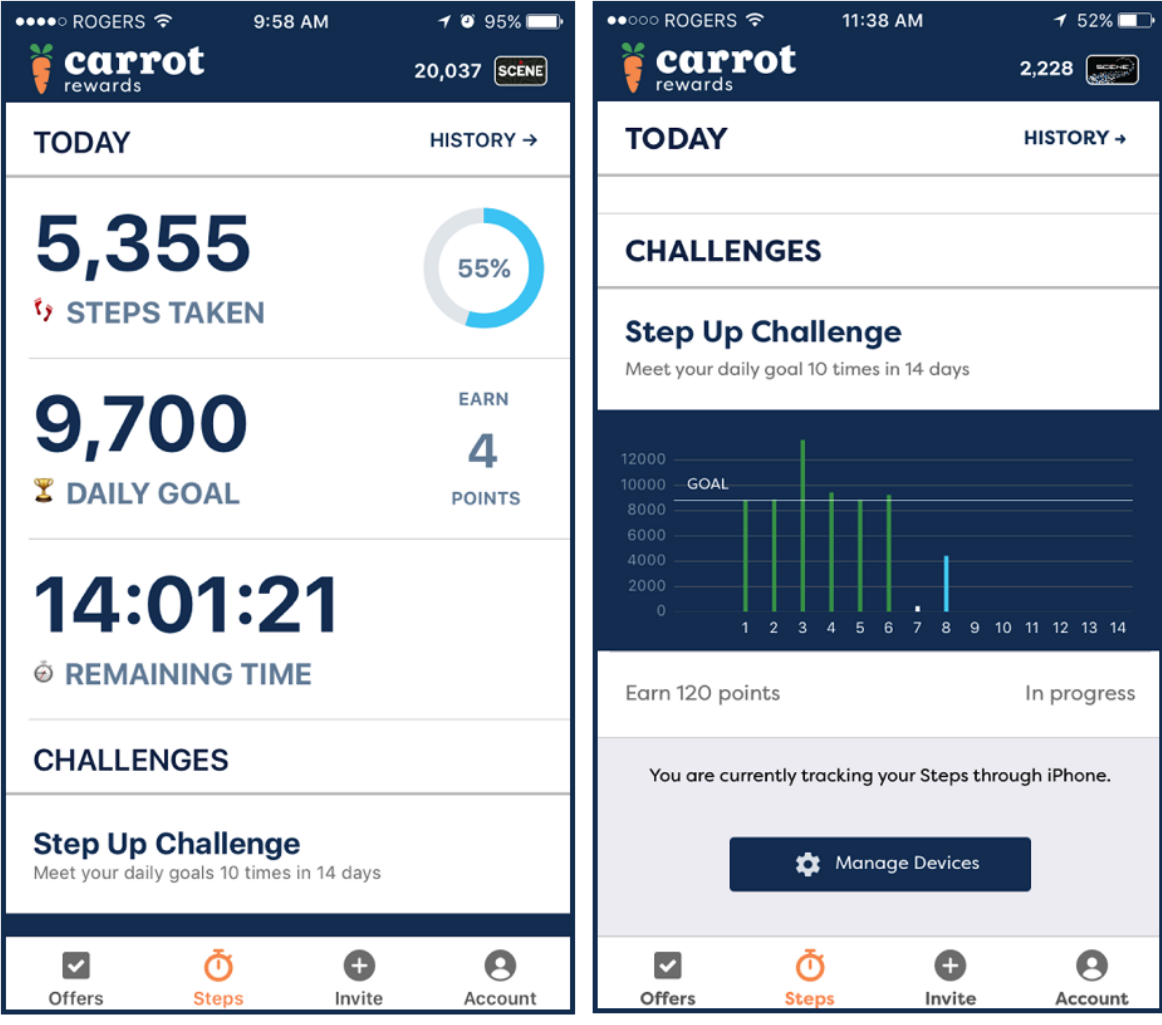
Figure 1. Carrot Rewards app’s “Steps” walking program